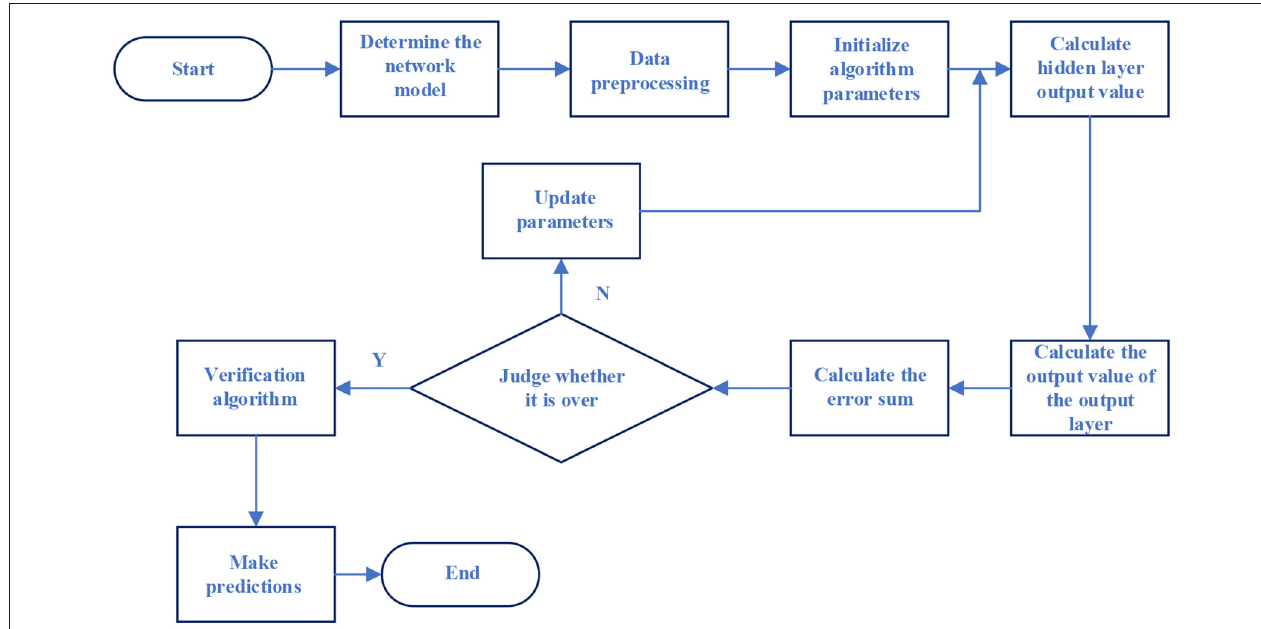
FIGURE 4 | The operation flow of the BPNN